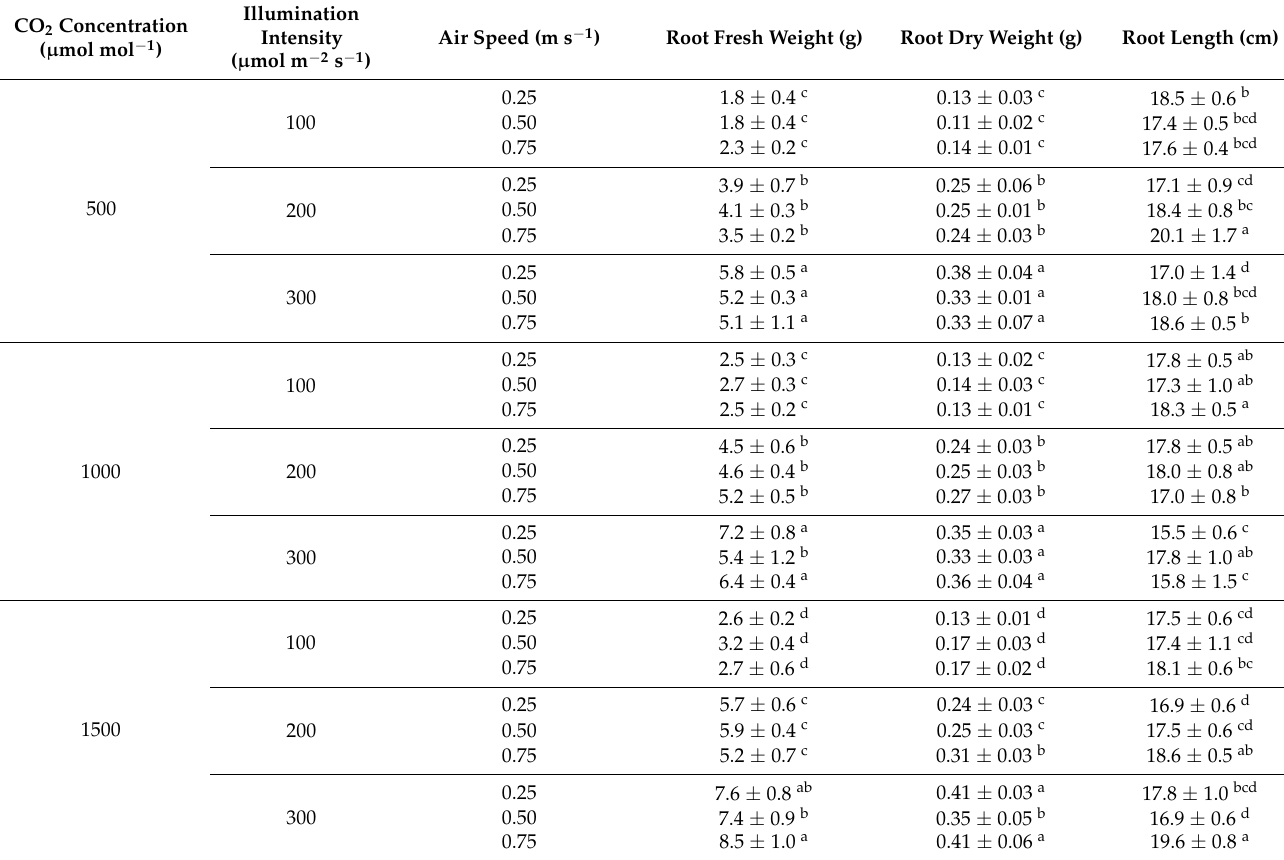
* indicates that the effect sizes of the two- and three-way interactions are significant at p ≤ 0.05. C, I, A indicate CO 2 concentration, illumination intensity and air speed, respectively. The values in the table represent the trivial effect size for values less than 10%, small effect size for values ranging from 10% to 30%, medium effect size for values ranging from 30% to 50%, and large effect size for values greater than 50%. Table 4. Fresh and dry weights of roots and roots length of lettuce plants as affected by CO 2 concentration, illumination intensity and air